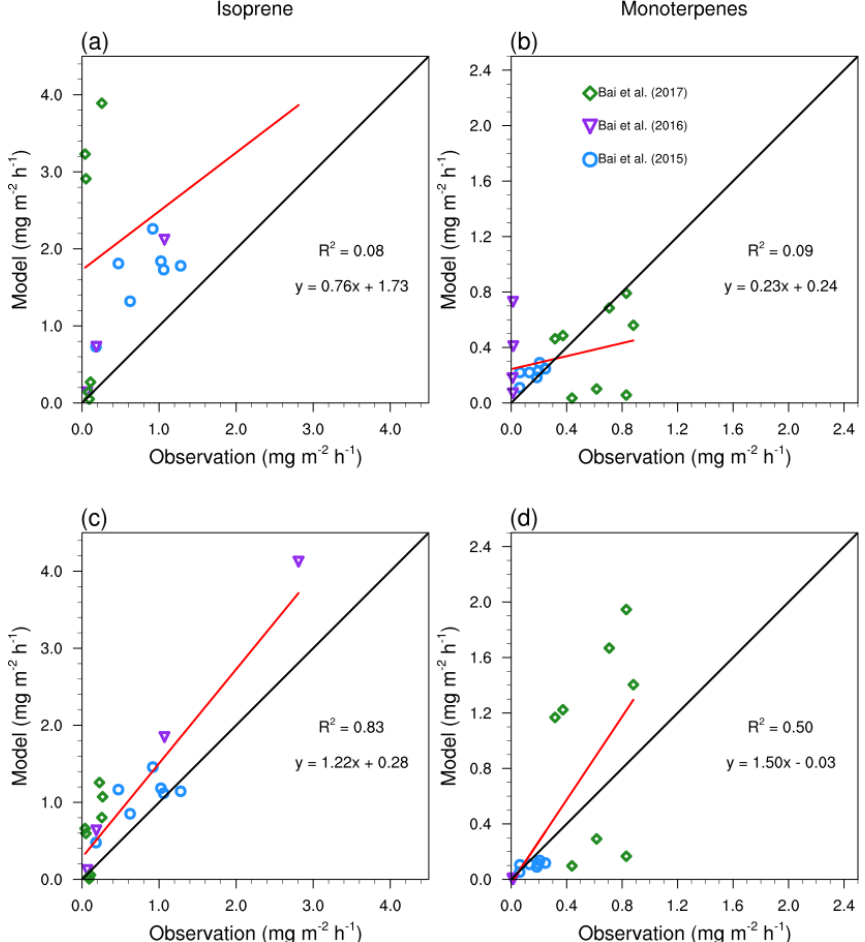
Figure 12. Validation of the model with flux measurements in China. Panels (a) and (b) show the performance of MEGAN with the default emission factors ( N = 19). Panels (c) and (d) show the performance of MEGAN with the emission factors derived from observations ( N =